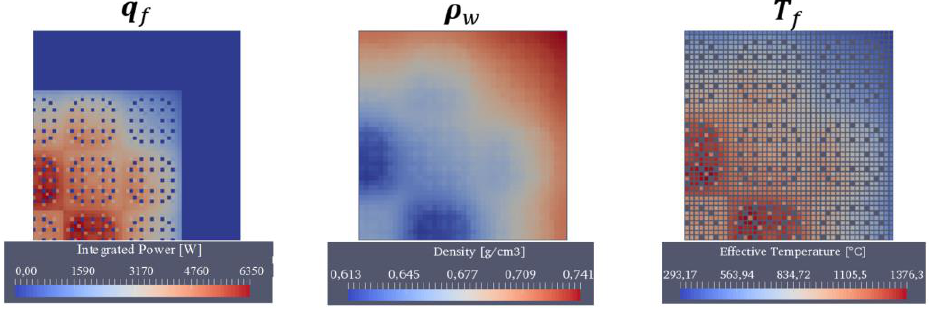
Figure 2: Radial mesh refinement (north-east quarter section of the core, reflector included for (cid:11) (cid:7) ): pin-cell neutronics, subchannel thermal-hydraulics and 1D heat conduction for every